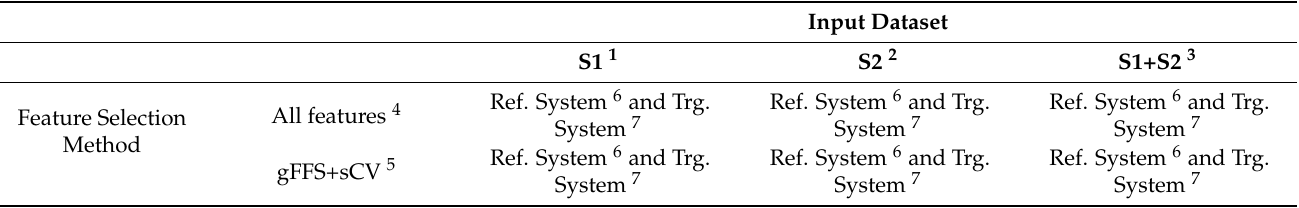
Table 2. Overview of conducted six model building approaches with three input datasets and two feature selection approaches. For each experiment, the classification accuracies from the reference system (‘Ref.System’) and target system (‘Trg.System’) were